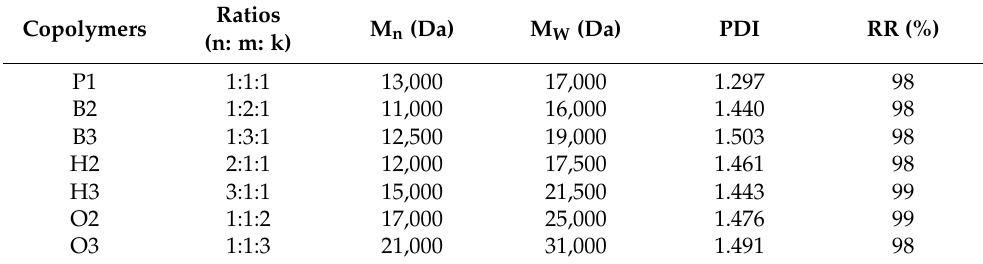
Scheme 1. Synthetic route of triblock copolymers. Table 1. Synthesized triblock copolymers Table 1. Synthesized triblock copolymers *.